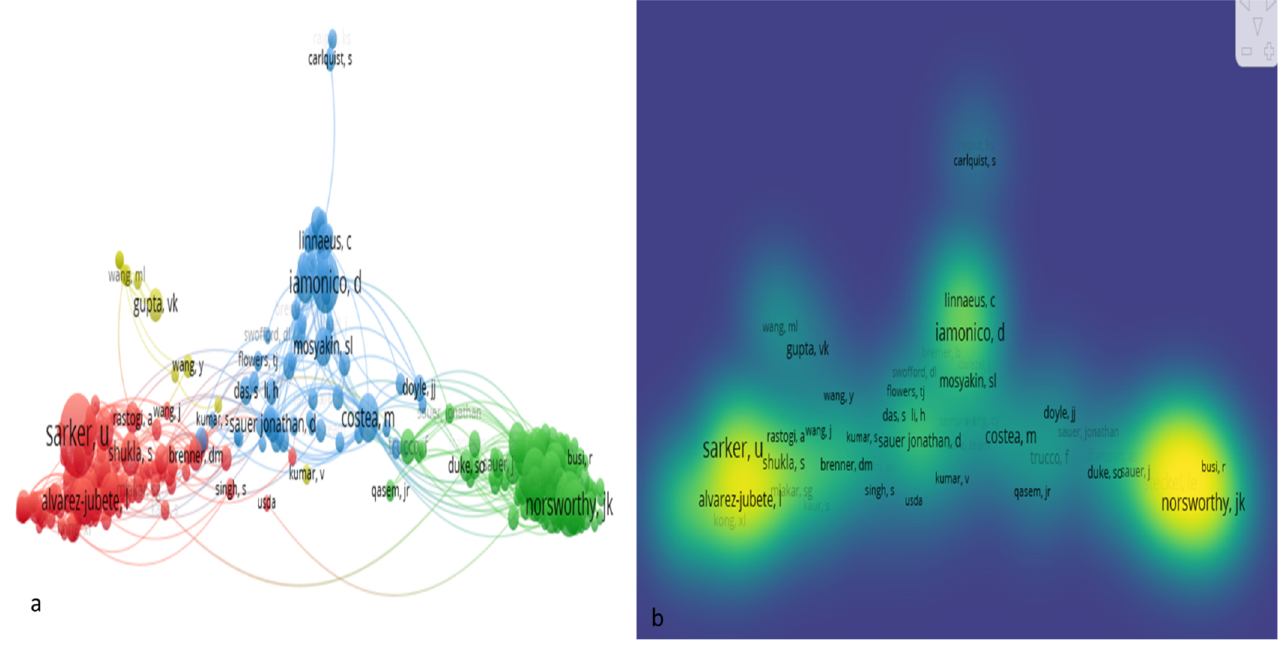
Figure 8. Author co-citation analysis on Amaranthus research from 2011 to 2020. ( a ) Overlay visual- ization, ( b ) Density